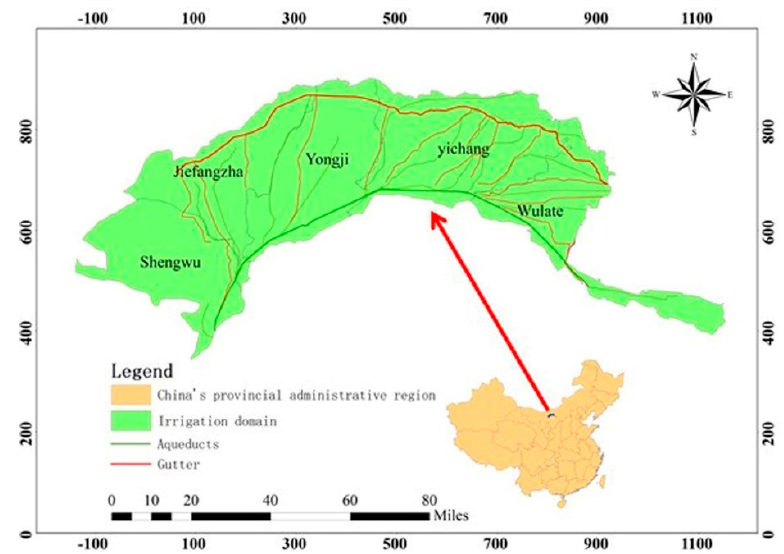
Figure 1. Irrigation district map.